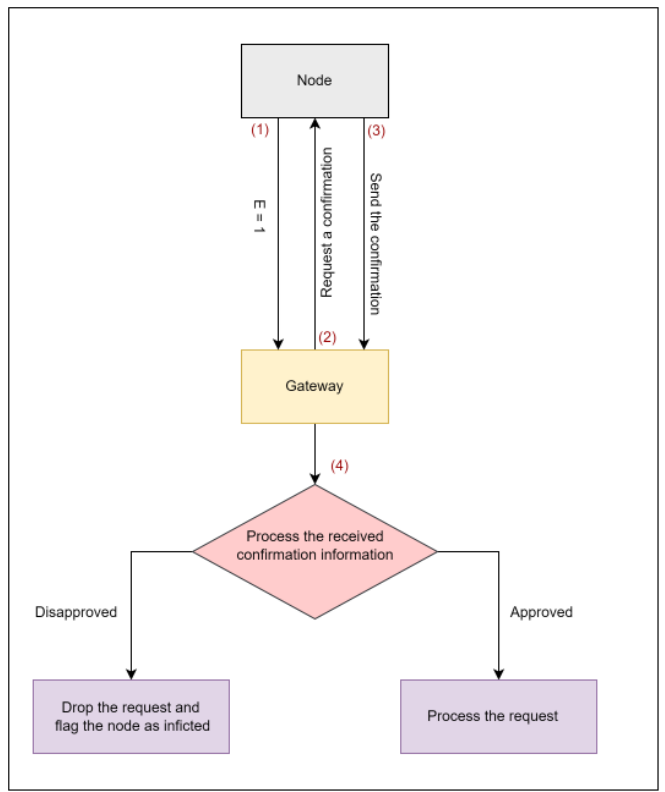
Figure 5. Sending and receiving the confirmation steps.